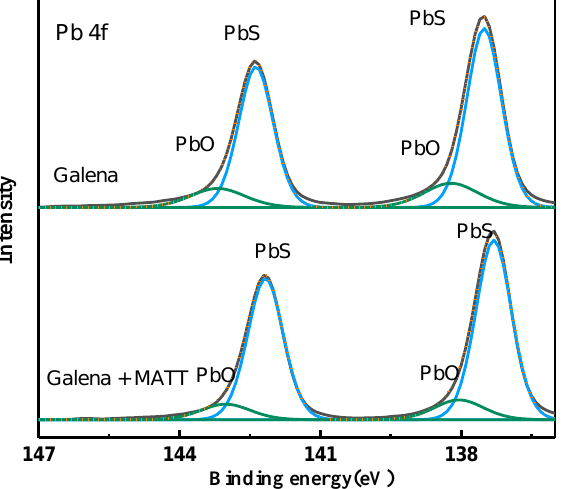
Figure 12. Pb 4f spectra of galena with and without MATT treatment.